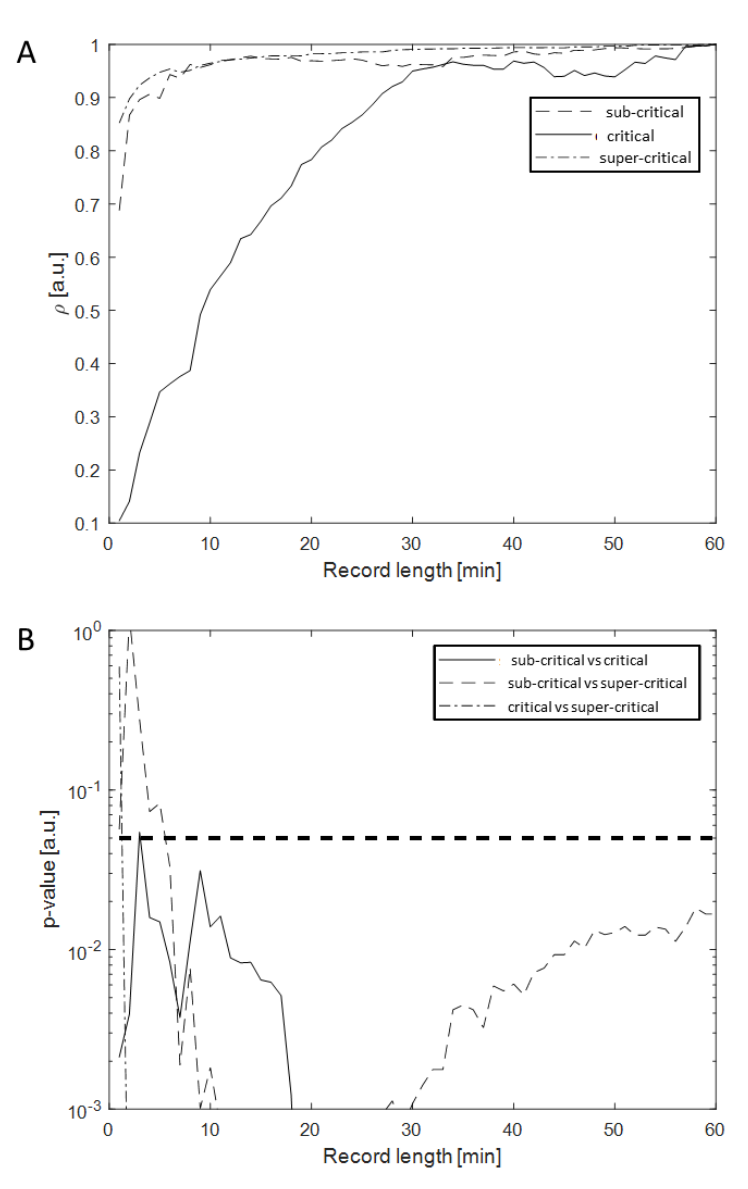
Figure 3. ( A ) Pearson correlation coefficient trend w.r.t. the recording time. The correlation is computed among the vector of ApEn values estimated from the record length reported in abscissa and the vector of ApEn values estimated from the full-length record (60 min). Each curve is relative to the different dynamical states depicted in Figure 1. ( B ) Trend of p -value, as estimated by a pairwise Wilcoxon signed rank test followed by a Bonferroni correction, w.r.t. the sub-record length. The dashed horizontal line represents the confidence level of